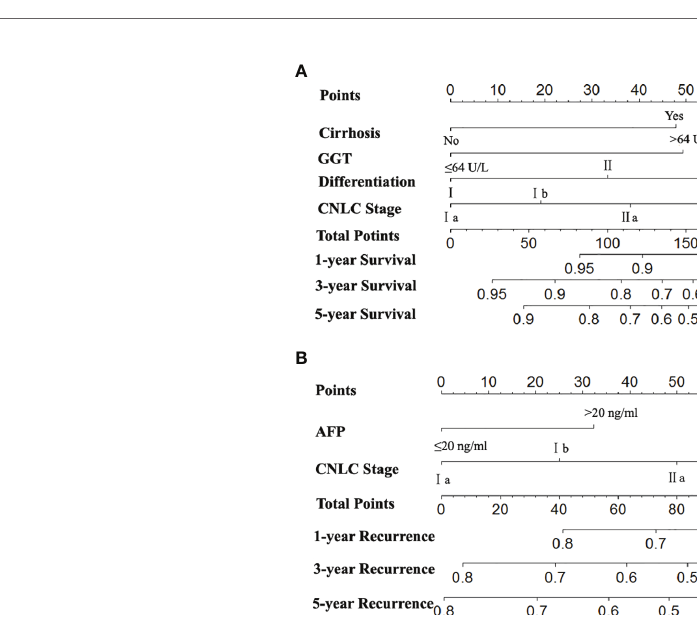
FIGURE 3 | Nomograms for predicting survival and recurrence of HCC patients after surgery. To calculate the probability of OS (A) and RFS (B) , straight upward lines are drawn to determine the points accrued. The sum of these points is plotted on the total points bar to the probability to yield the 1-, 3-, and 5-year survival or recurrence